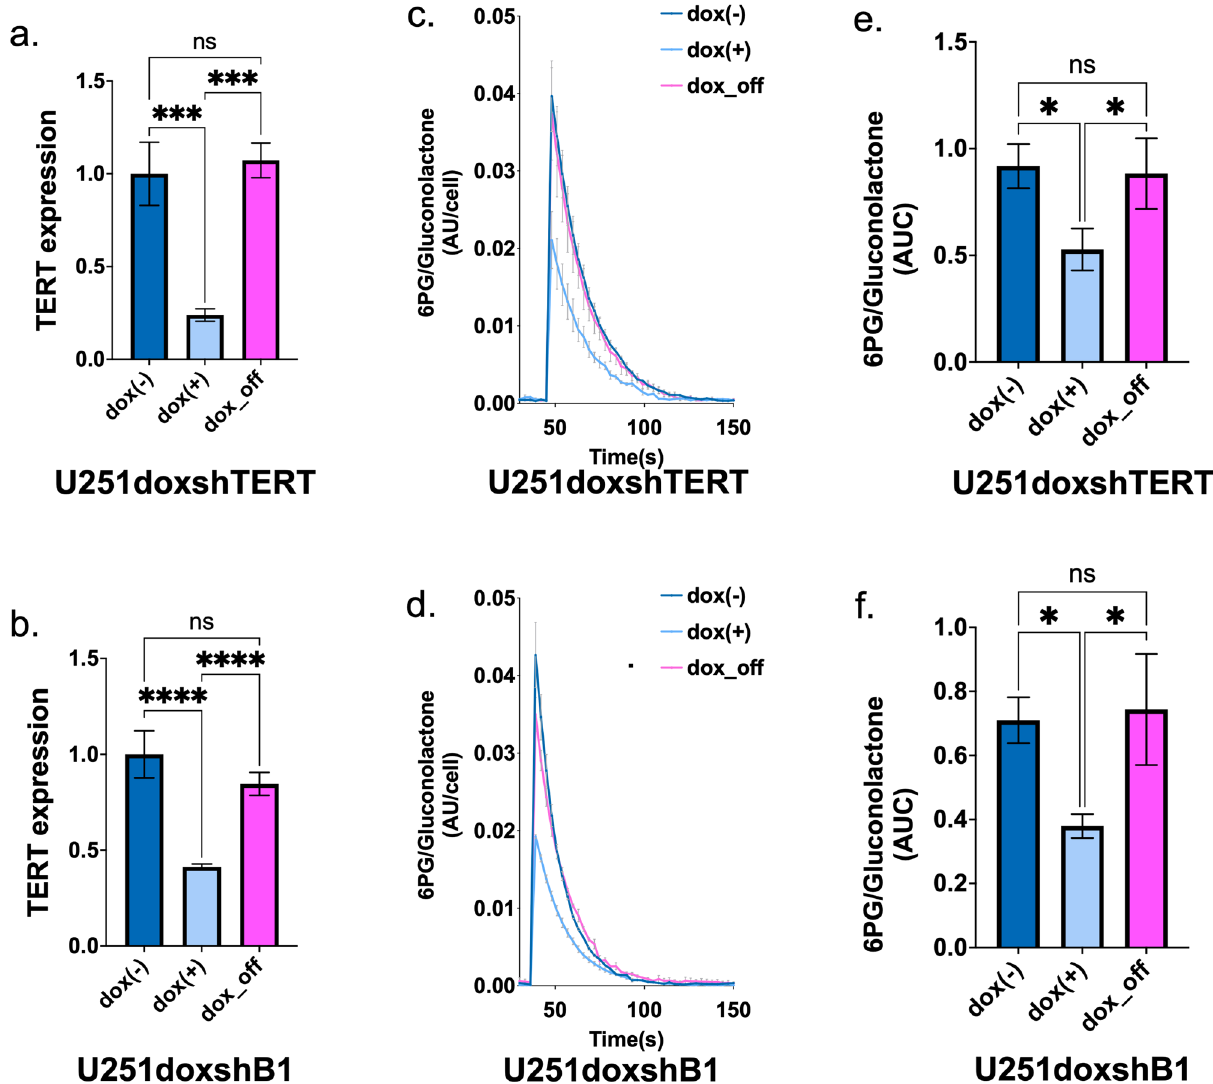
Figure 4. ( a ) TERT expression comparing dox( −), dox( +), and dox_off for U251doxshTERT cells. ( b ) TERT expression comparing dox( −), dox( +), and dox_off for U251doxshB1 cells. ( c ) Temporal evolution of [1- 13 C]6PG comparing U251doxshTERT cells with dox( −), dox( +), and dox off. ( d ) Temporal evolution of [1- 13 C]6PG comparing U251doxshB1 cells with dox( −), dox( +), and dox off. ( e ) The AUC of [1- 13 C]6PG comparing U251doxshTERT cells with dox( −), dox( +), and dox off. ( f ) The AUC of [1- 13 C]6PG comparing U251doxshB1 cells with dox( −), dox( +), and dox